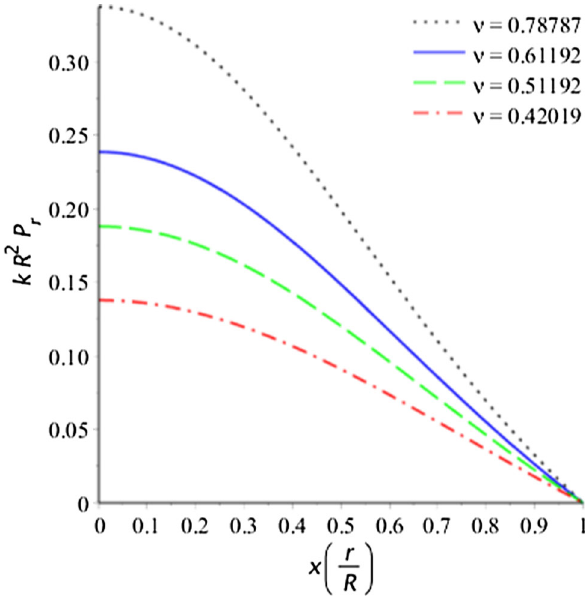
Fig. 3 Graphical representation of the radial pressure